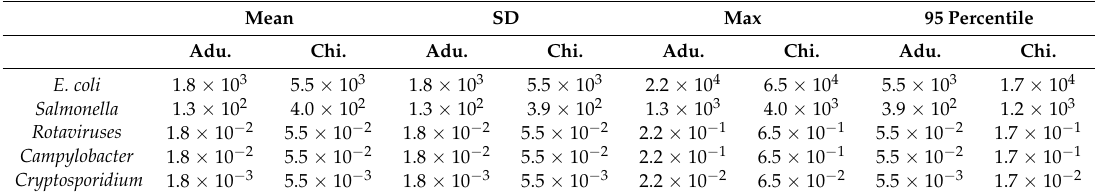
Table 3. Average dose of pathogens per event (MPN).